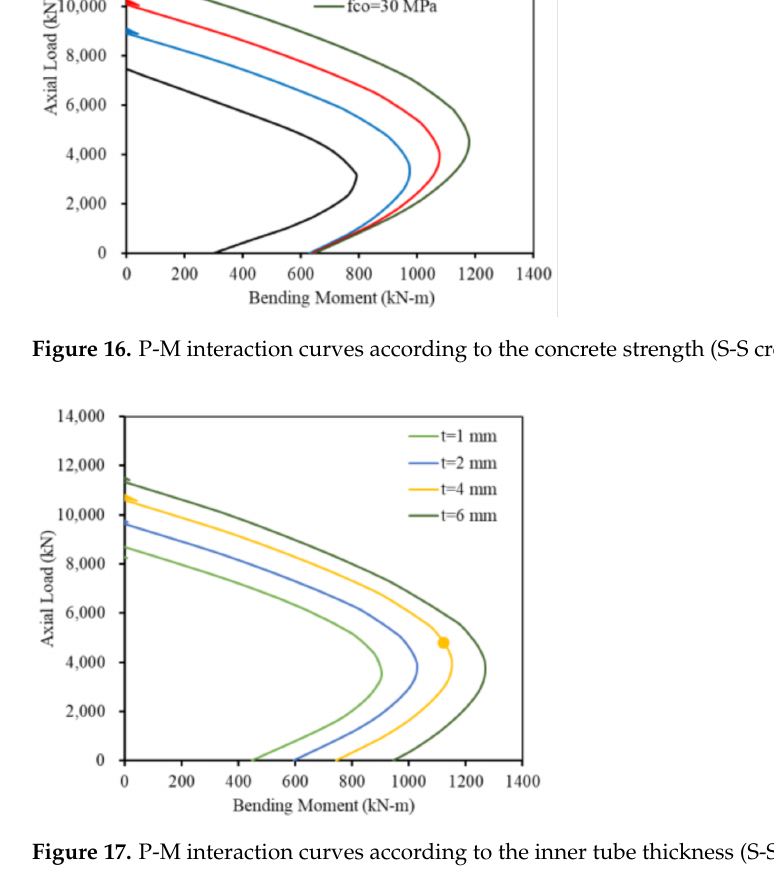
Figure 17. P-M interaction curves according to the inner tube thickness (S-S cross-section).